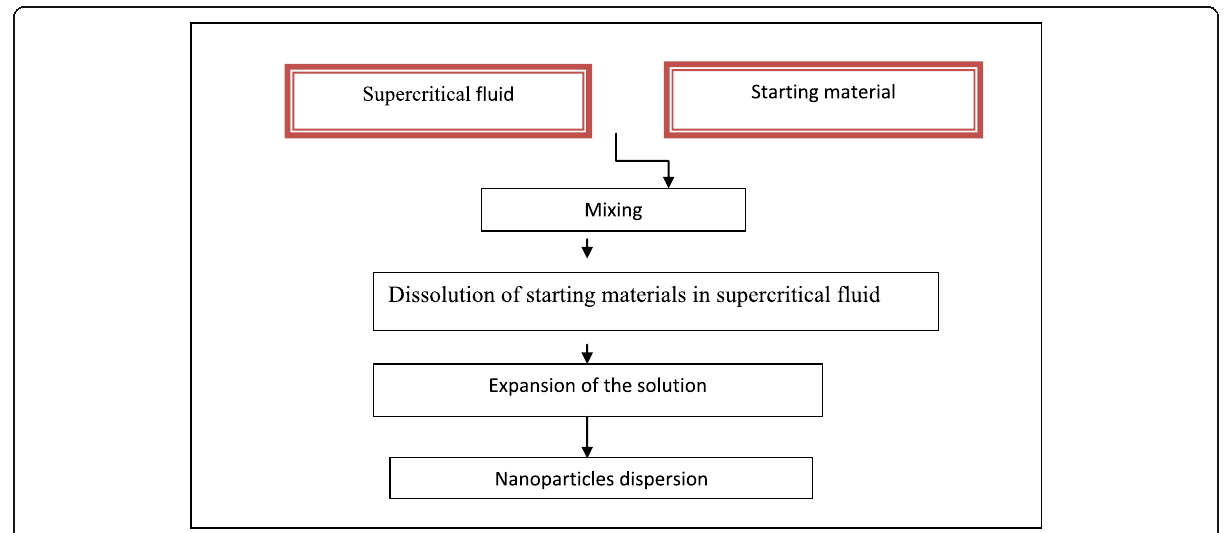
Fig. 7 Supercritical fluid extraction of